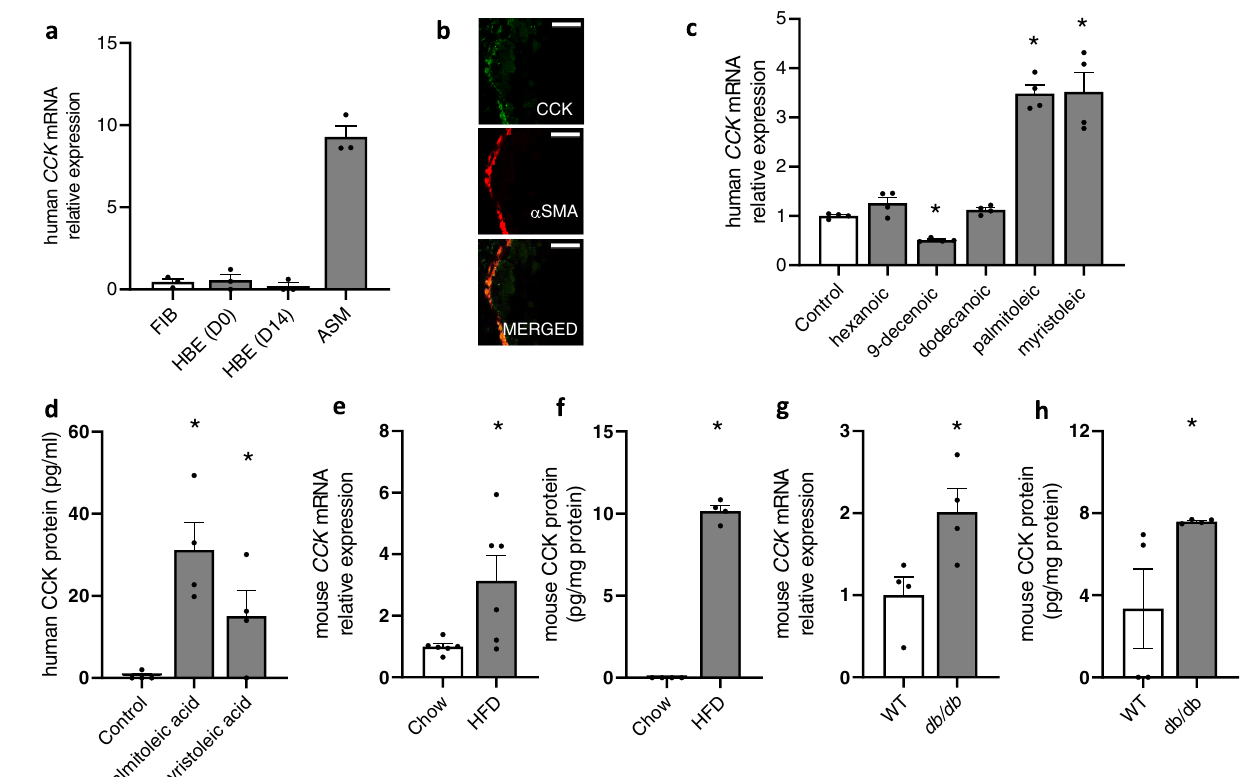
Fig.3|CCKexpressioninASMandinthelung.a qRTmeasurementofCCKmRNA expression in airway cells. FIB: lung fi broblasts; HBE: human bronchial epithelia cells;HBE(D0):day0ofinitiationofair-liquidinterface(ALI)culture;HBE(D14):day 14 post-ALI; ASM: airway smooth muscle cells. ( n =3 biologically independent samples per group). b Immunostaining of mouse lung tissue section for CCK (green). α -SMA ( α -smooth muscle actin, red) was used as a marker of ASM.